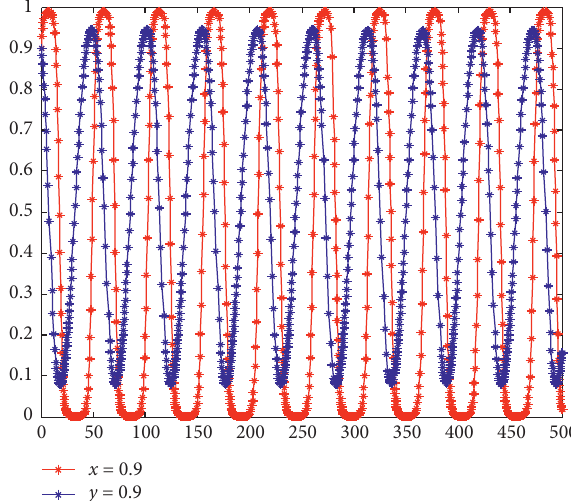
Figure 2: Influence of critical points of government subsidies on the formation of the green dairy industry